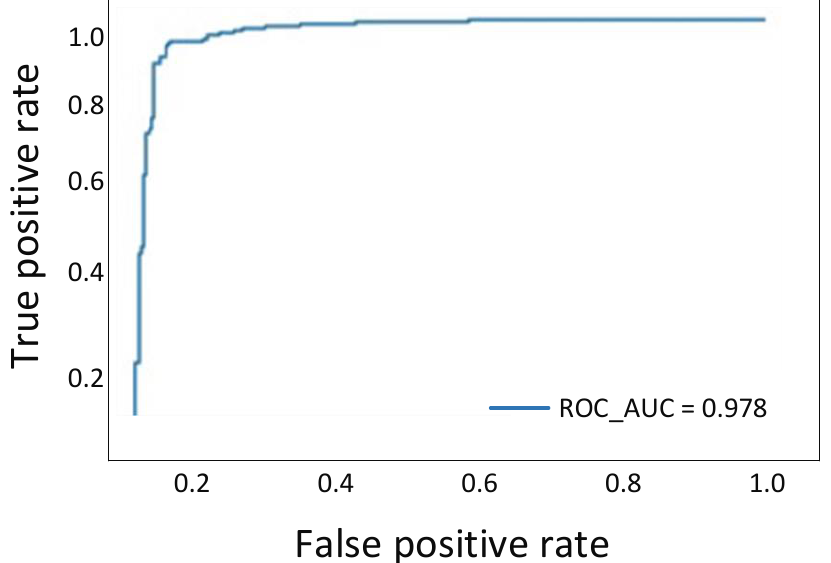
Figure 17. Flow diagram of the proposed